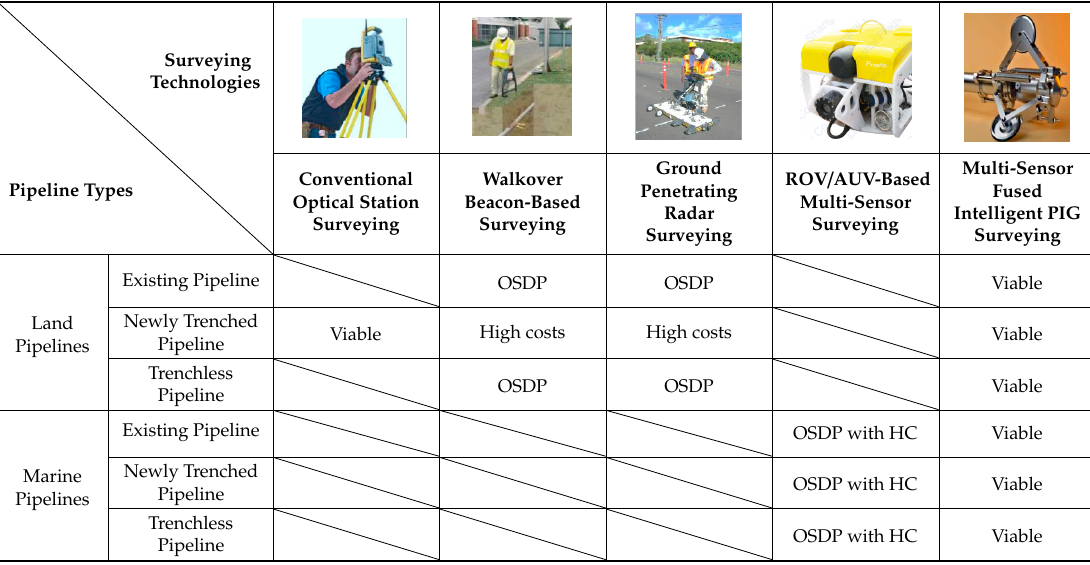
Table 1. The comparison between various pipeline surveying technologies.